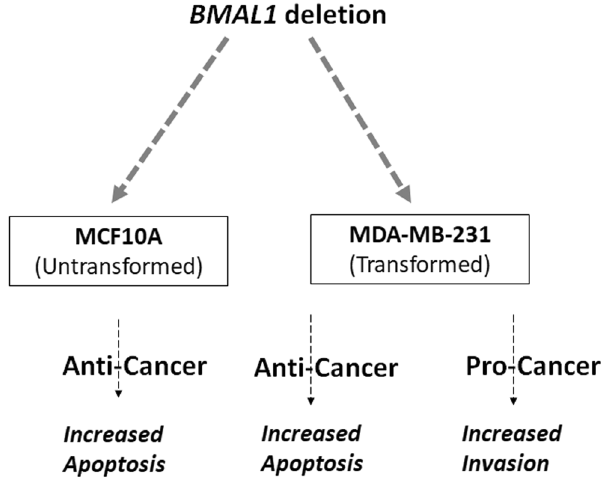
Figure 6. Pro- and anti-cancer effects of BMAL1 knockout mutation. Knockout of BMAL1 by CRISPR in non- tumorigenic MCF10A and invasive MDA-MB-31 cell lines had an anti-cancer effect by sensitizing these